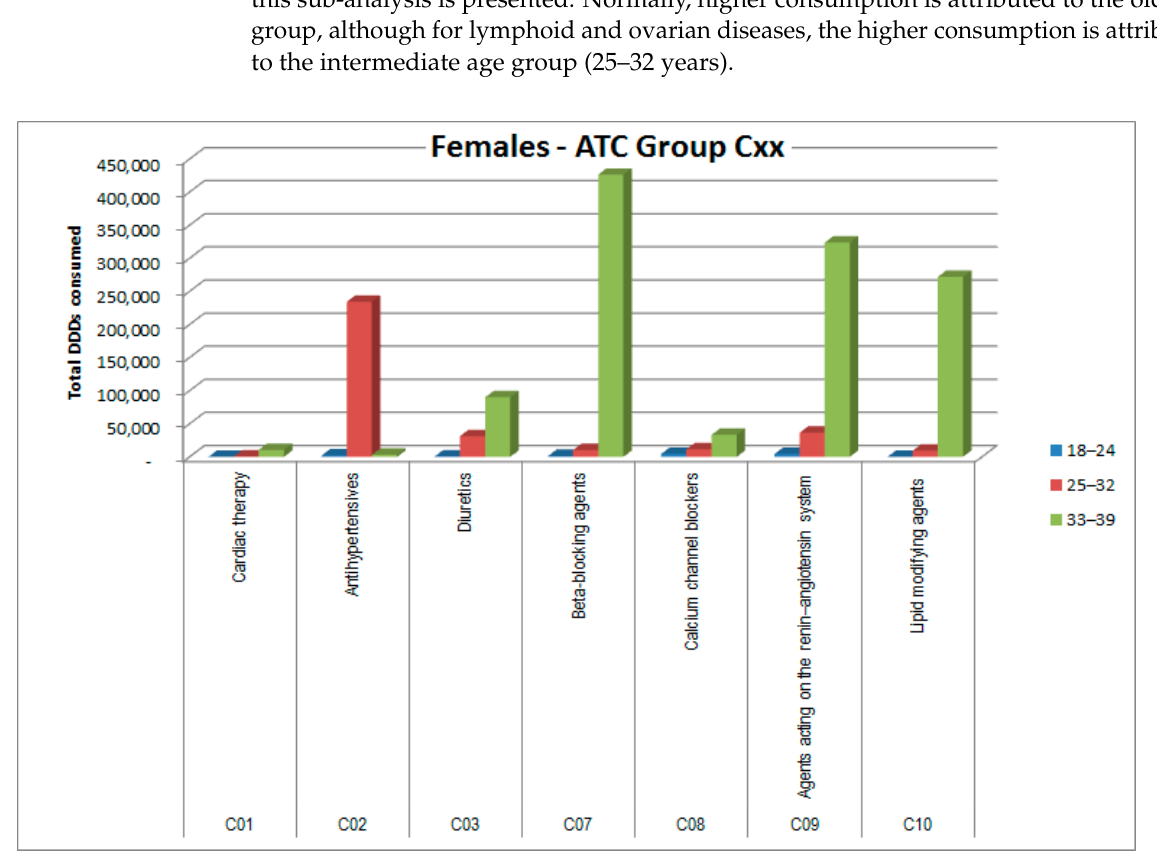
Figure 6. DDD consumption for females, ATC group Cxx.